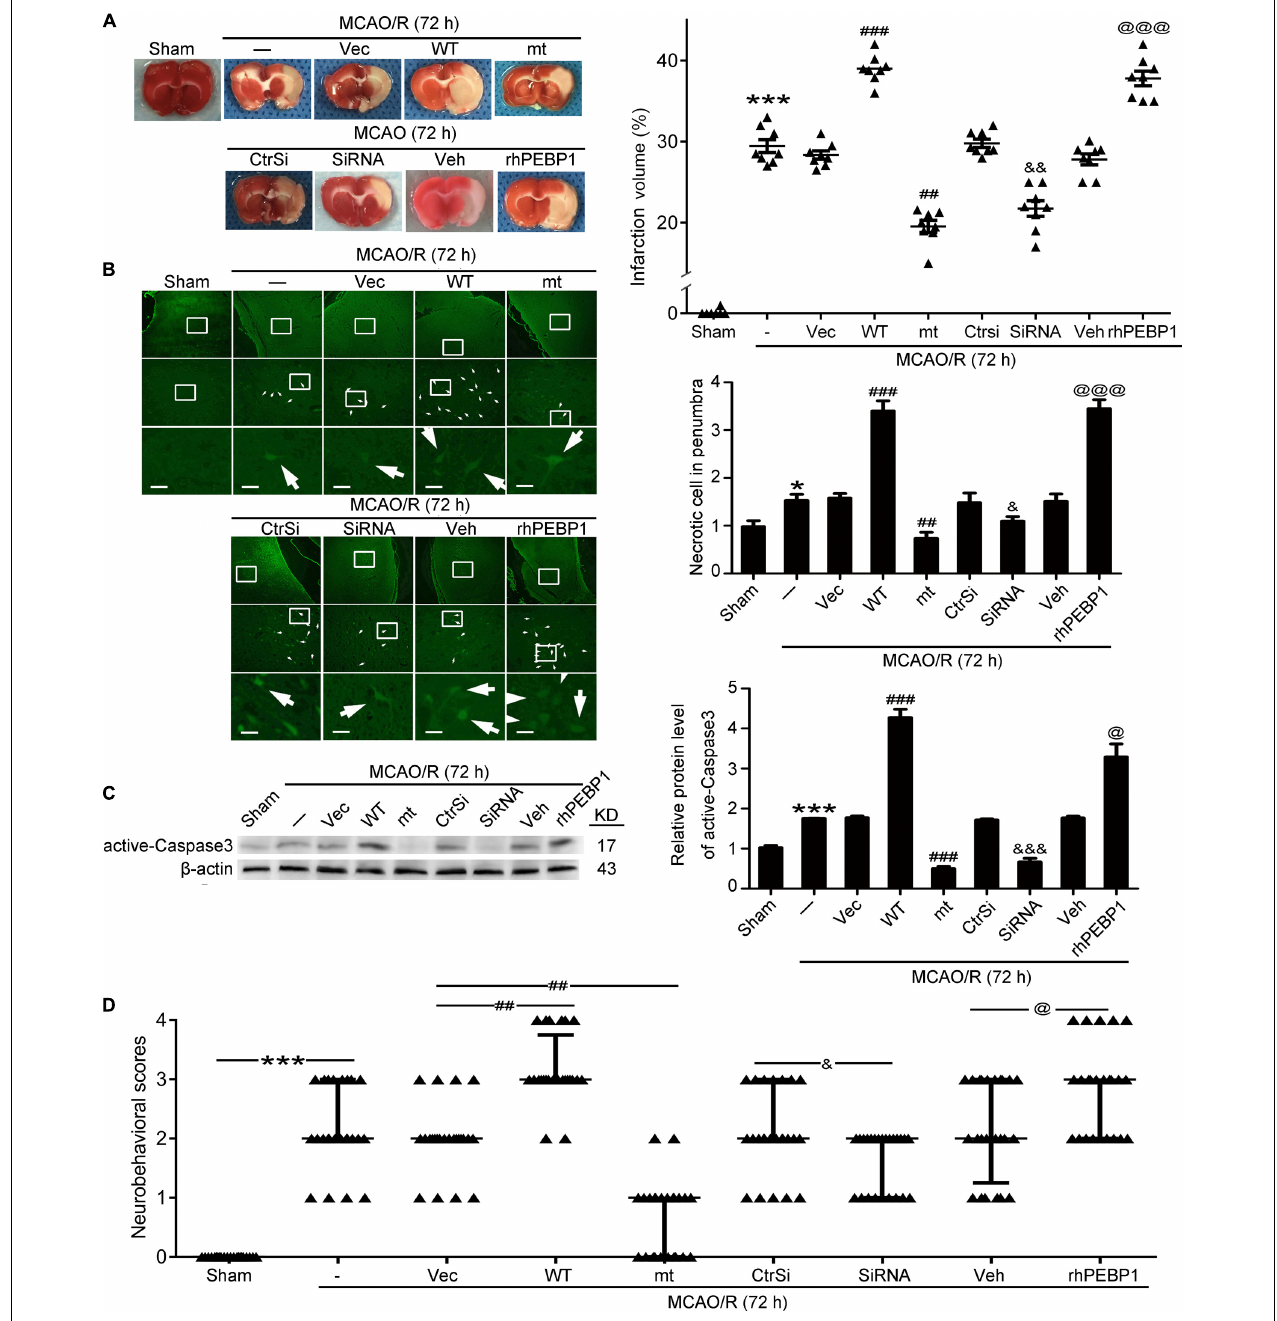
FIGURE 6 | Effects of PEBP1 overexpression and knockdown and rhPEBP1 treatment on brain injury at 72 h after MCOA/R surgery. (A) TTC staining analysis and the quantification of the infarct volume. The mean values for MCAO/R group were normalized to 1.0. ∗∗∗ p < 0.001 vs. sham group, ### p < 0.001 vs. MCAO/R + vector group, ## p = 0.0037 vs. MCAO/R + vector group, && p = 0.0021 vs. MCAO/R + control-siRNA group, @@@ p < 0.001 vs. MCAO/R + vehicle group ( n = 8). (B) FJB staining. Arrows indicated FJB-positive neurons. Scale bar = 60 µ m. ∗ p = 0.011 vs. sham group, ### p < 0.001 vs. MCAO/R + vector group, # p = 0.038 vs. MCAO/R + vector group, && p = 0.0045 vs. MCAO/R + control-siRNA group, @@@ p < 0.001 vs. MCAO/R + vehicle group ( n = 6). (C) Western blot analysis and quantification of the protein level of active-Caspase3. ∗∗∗ p < 0.001 vs. sham group, ### p < 0.001 vs. MCAO/R + vector group, &&& p < 0.001 vs. MCAO/R + control-siRNA group, @ p = 0.034 vs. MCAO/R + vehicle group ( n = 6). (D) Clinical behavior scores. ∗∗∗ p < 0.001 vs. sham group, # p = 0.044 vs. MCAO/R + vector group, && p = 0.0099 vs. MCAO/R + control-siRNA group, @ p = 0.044 vs. MCAO/R + vehicle group ( n = 14). In (B,C) , the mean values for sham group were normalized to 1.0. Statistical comparisons between groups were performed using one-way analysis of variance followed by either a Dunnett’s or a Tukey’s post hoc test, the former for comparisons to a single control group, the latter to compare across multiple groups. WT: wild type; MT: PEBP1 with Ser153 mutated to